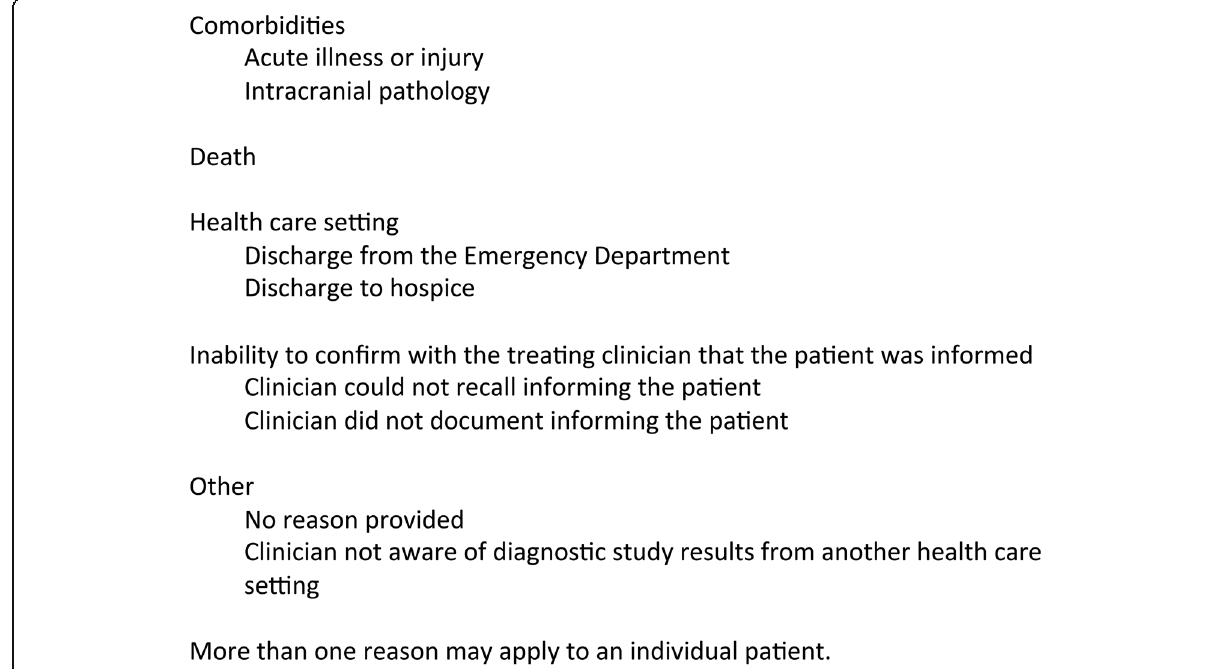
Fig. 2 Reasons for lack of reporting of SBIs to patients